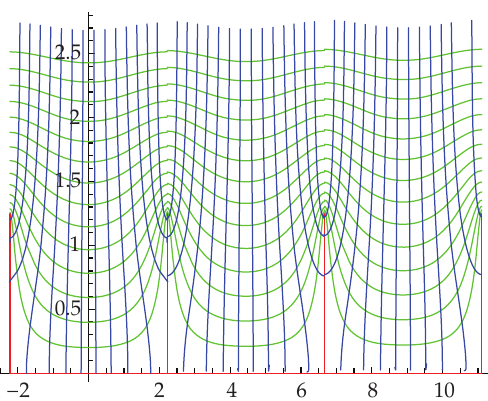
(cid:10) z (cid:5) cos (cid:5) x/ 2 (cid:6) / 0